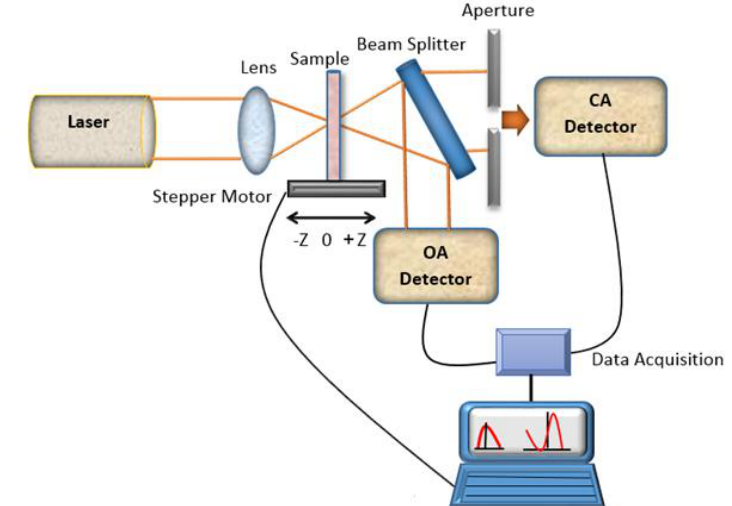
Fig.1: Schematic diagram of the single beam measurement experimental